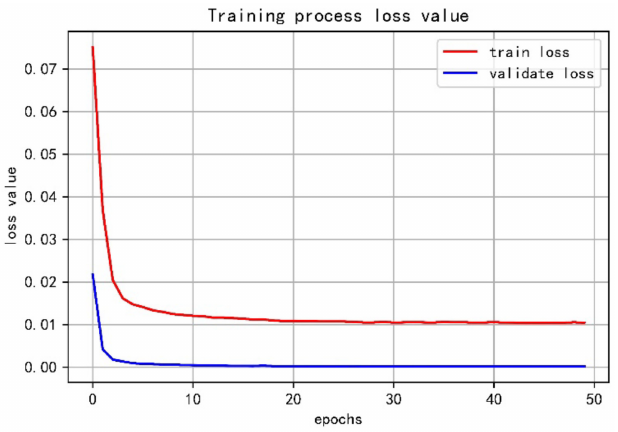
Figure 11. Loss value